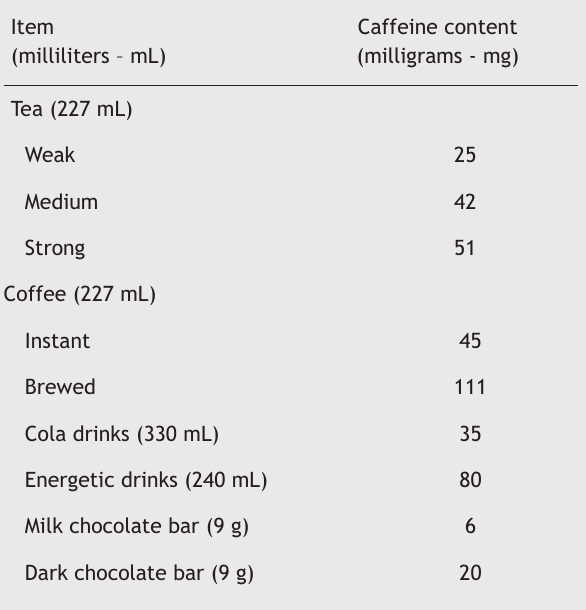
Table 1 Main types of foods and beverages containing